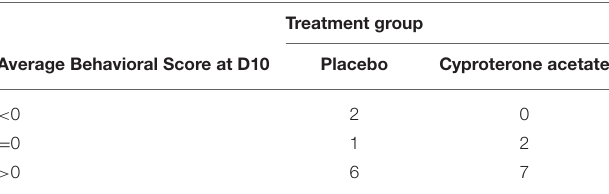
TABLE 8 | Numbers of subjects whose behavioral score was worse ( < 0), identical ( = 0) or better ( > 0) at D10 than that of reference (at D0). Treatment